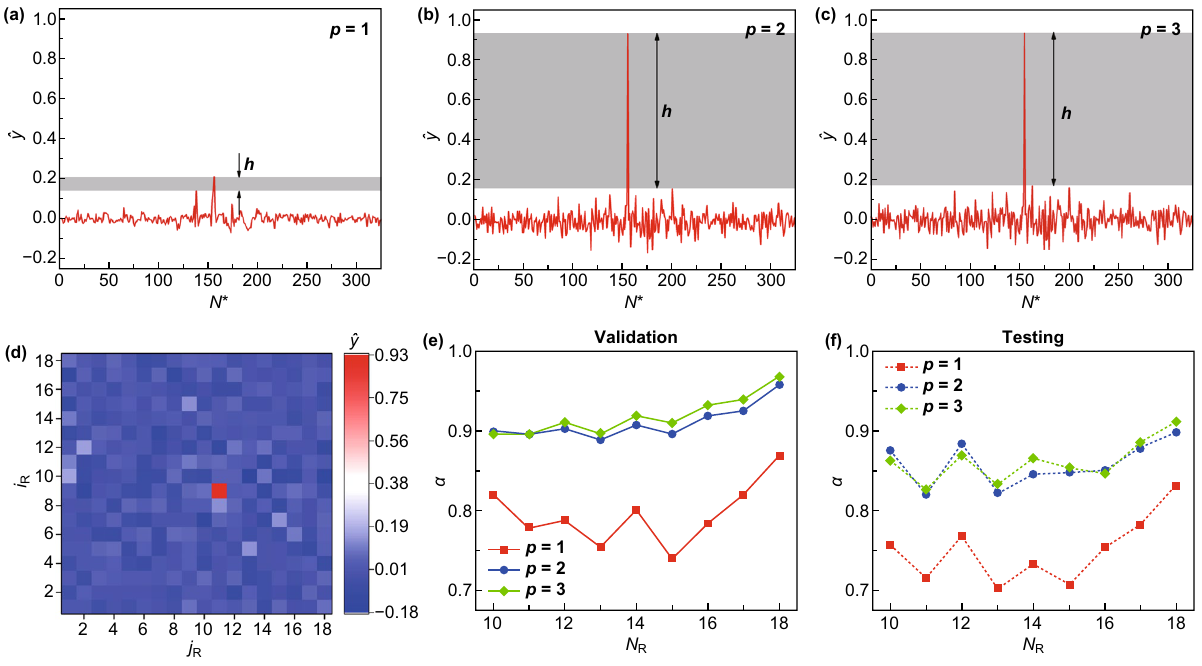
Fig. 4 Machine learning predictions of a single-atom vacancy with domain discretization. a – c Predicted label vectors on an 18-by-18 discretiza- tion with kernel degrees 1, 2, and 3, respectively. The margin h is illustrated by the gray areas. d 2D presentation of the predicted label vector of kernel degree 2. e Validation and f testing accuracies with kernel degrees p ∈ { 1,2,3 } , as a function of N